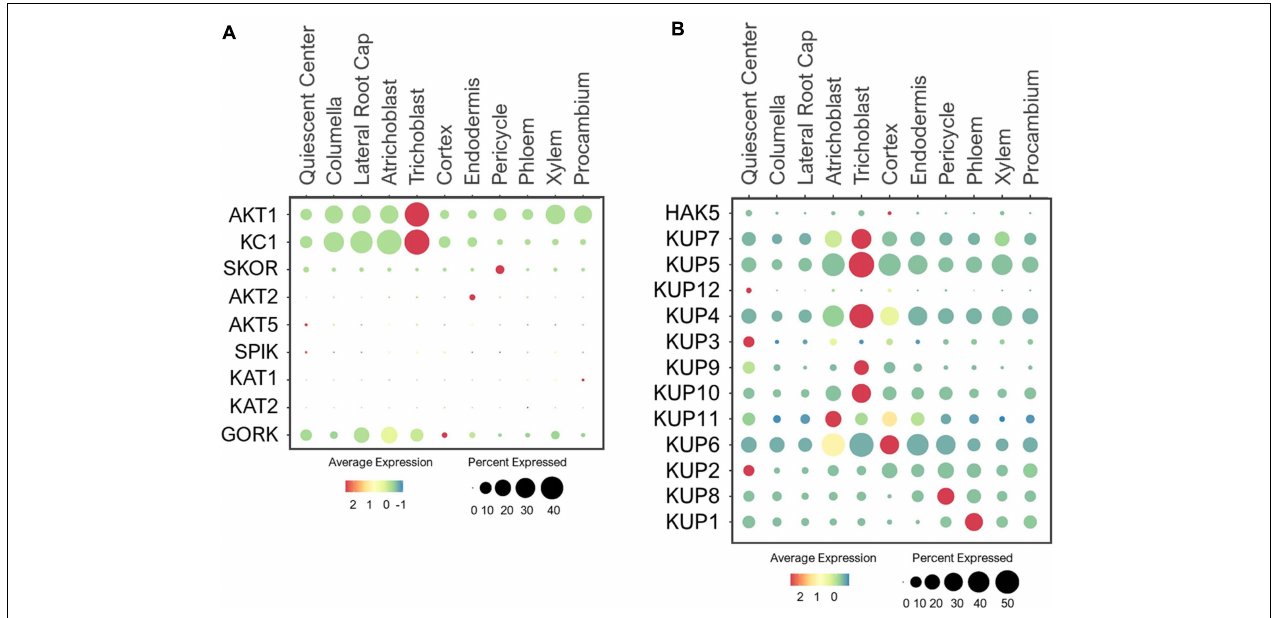
FIGURE 10 | Expression of the (A) Shaker- type channels (B) KUP transporters in Arabidopsis root single cells. In dot plots, the circle size represents the proportion (%) of cells expressing a given gene, and the color of scale bar represents the mean expression (natural log +1 pseudocount).